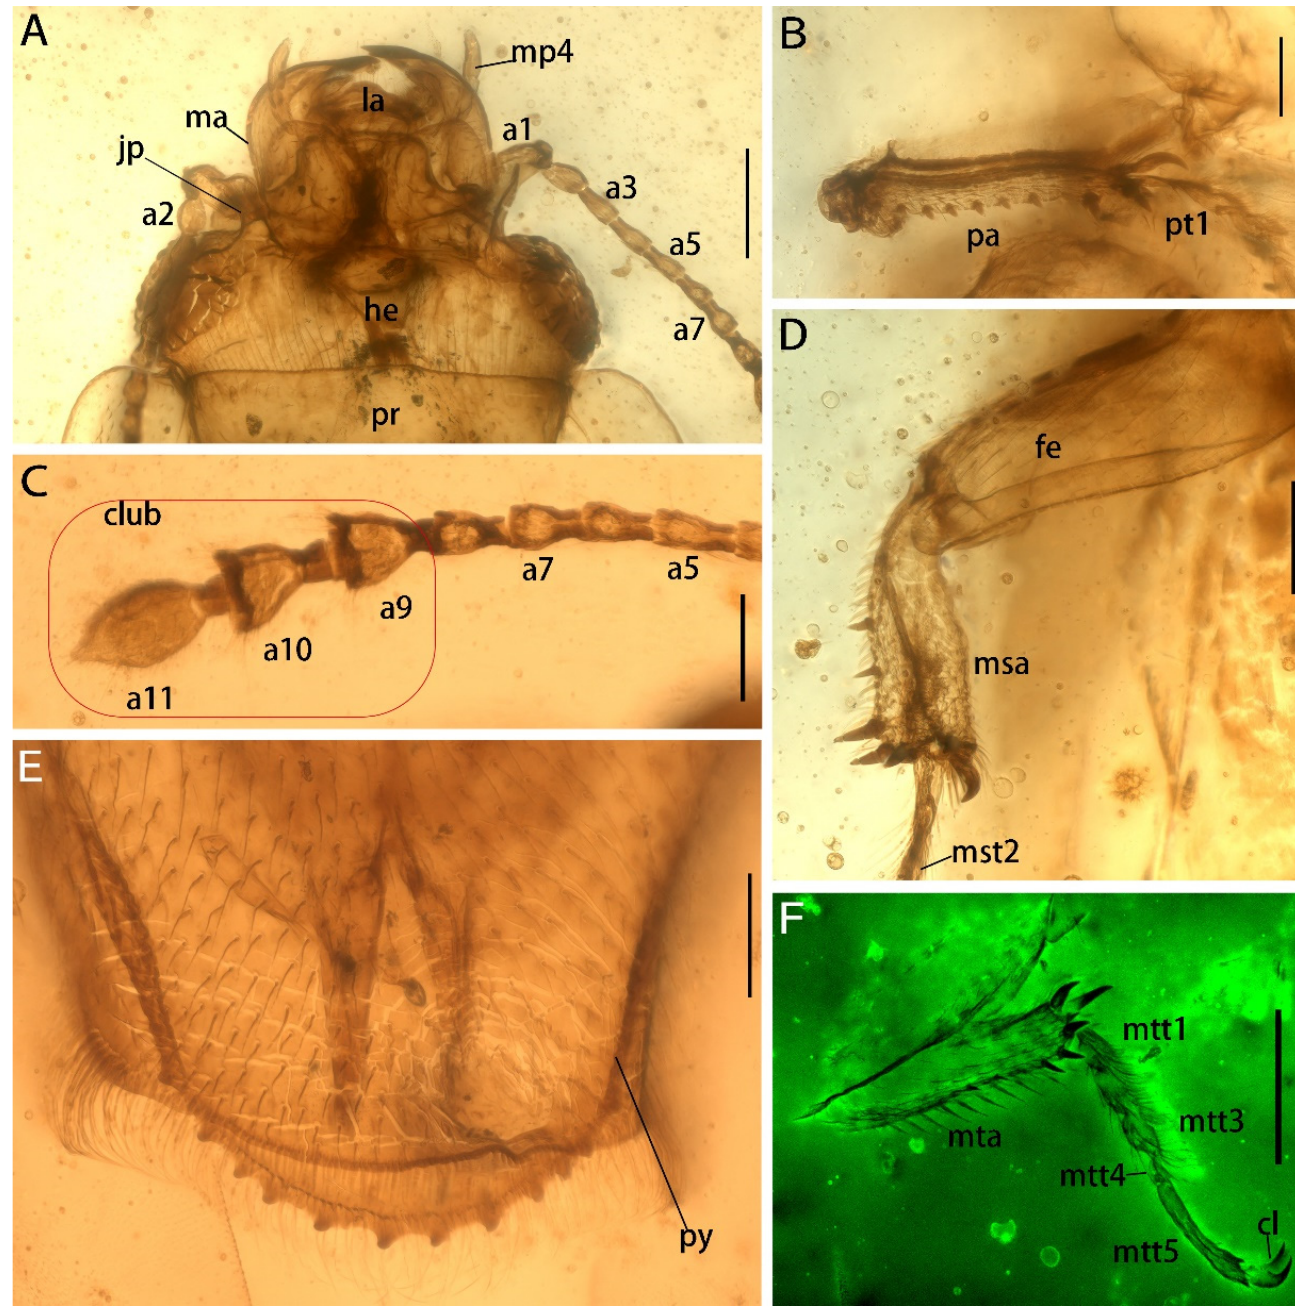
Figure 3. Details of Protonitidula neli gen. et sp. nov. from mid-Cretaceous Burmese amber (holotype, NIGP200399) under a confocal laser scanning microscope (CLSM), while others are under transmitted light. ( A ) Ventral view of head. ( B ) Protibia. ( C ) Antenna 5–11. ( D ) Mesotibia. ( E ) Pygidium. ( F ) Metatibia. Abbreviations: jp, jugular process; he, head; ma, mandible; la, labrum; ey, eye; pr, pronotum; mp4, maxillary palpomere 4; a1, antennomere 1; a3, antennomere 3; a5, antennomere 5; a7, antennomere 7; a9, antennomere 9; a10, antennomere 10; a11, antennomere 11; la, labrum; pa, protibial; msa, mesotibia; mta, metatibia; fe, femur; py, pygidium; pt1 protarsomere 1; mst2 mesotarsomere 2; mtt1, metatarsomere 1; mtt3, metatarsomere 3; mtt4, metatarsomere 4; mtt5, metatarsomere 5; cl, claw. Scale bars: 200 µ m in A and F, 100 µ m in